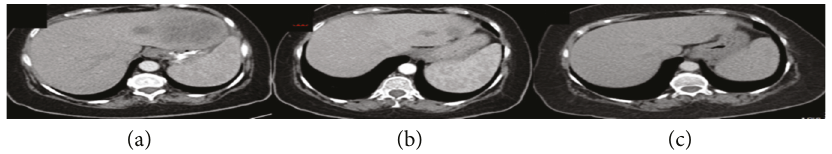
Figure 2: CT scan that shows liver lesions (a) before starting 1st line chemotherapy and (b) before starting immunotherapy. (c) Last CT scan showing continuous